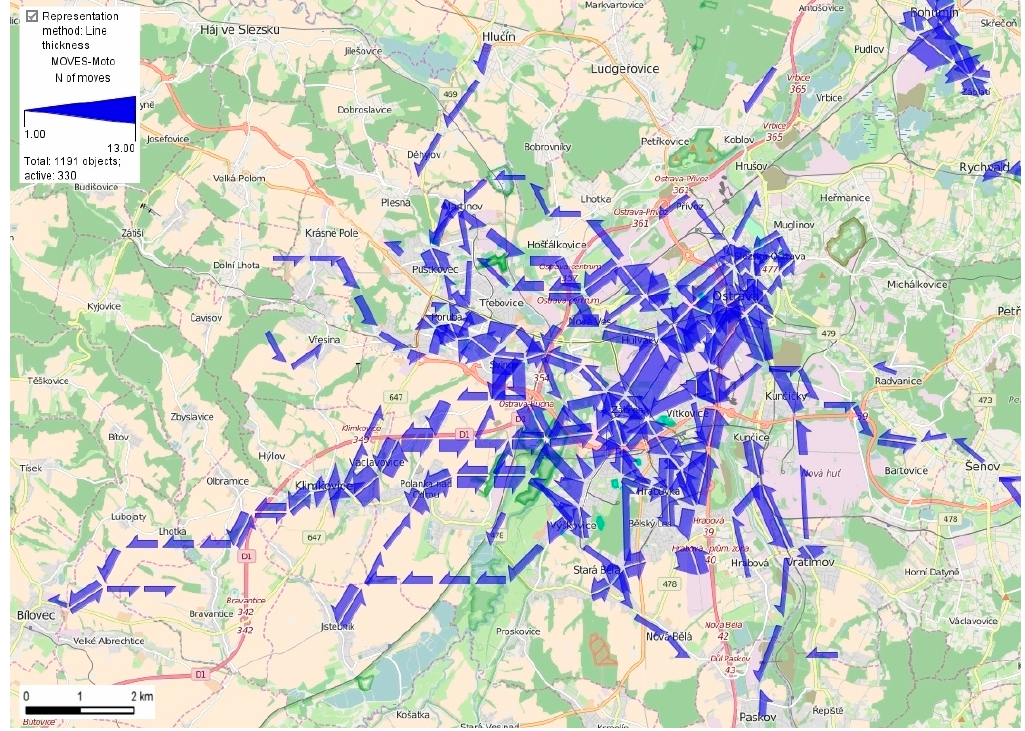
Figure 17. Dominant directions of movement in Ostrava according to car transport.